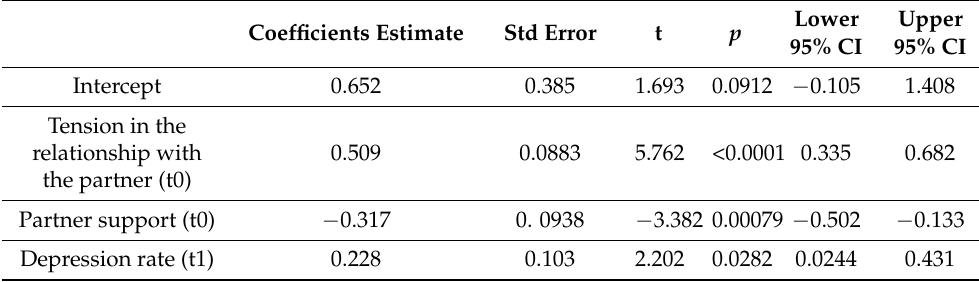
Table 3. Coefficient estimates of the regression model. The total IPV score during the t1 served as the dependent variable.